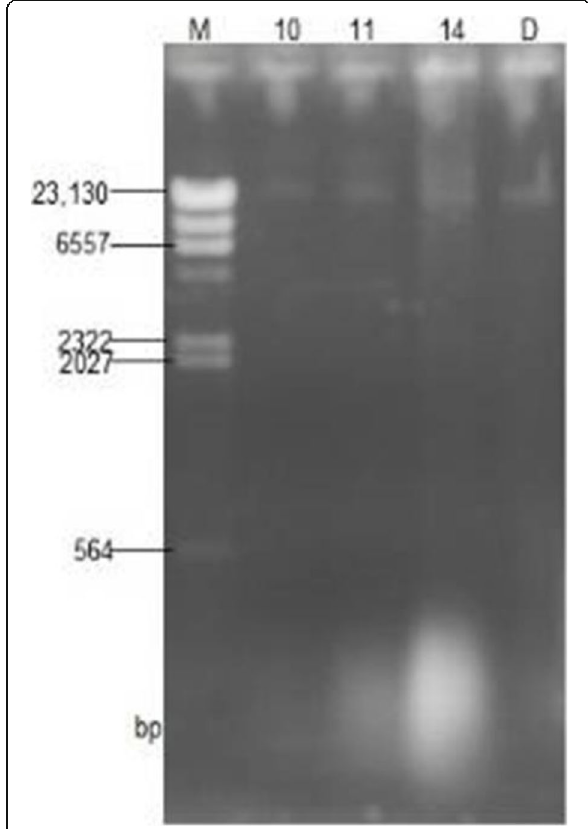
Fig. 7 Molecular weight bands of different purified bacteriocins on SDS PAGE